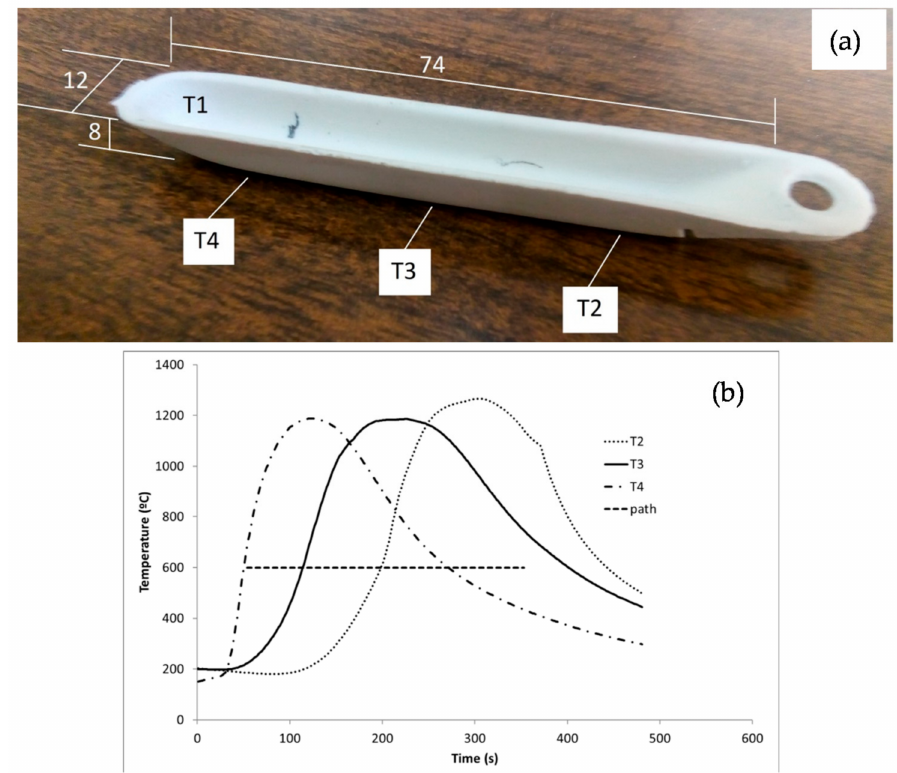
Figure 10. ( a ) Image of the crucible used in the experiments, distances in millimeters. Position of the thermocouples: T1 located inside of the crucible, T2, T3, and T4 located outside at the bottom of the crucible; ( b ) measurements of the thermocouples for a sample treated with concentrated solar